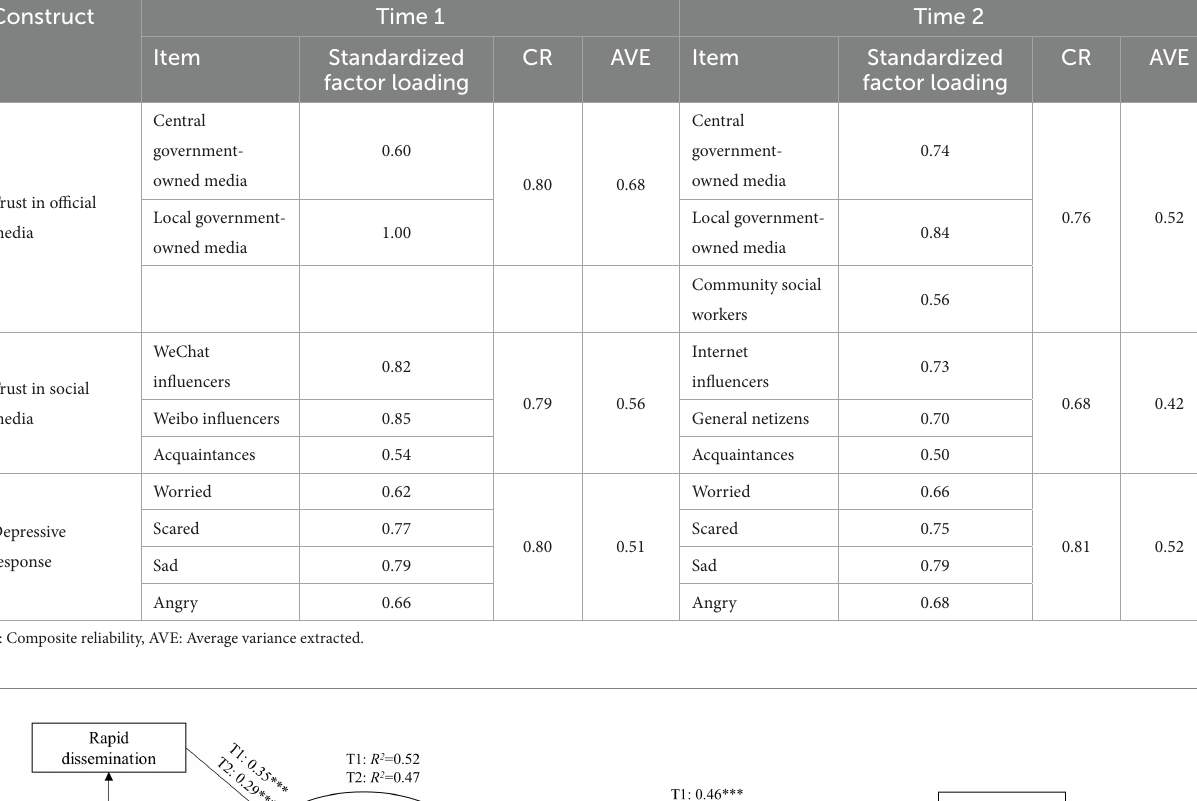
TABLE 4 The standardized factor loadings, composite reliability (CR), and average variance extracted (AVE) of each construct in measurement model at Time 1 and Time 2. Construct